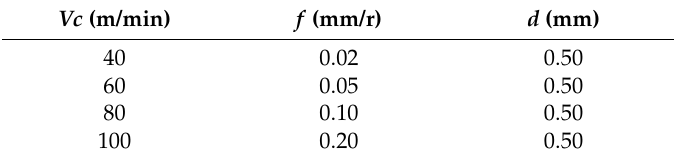
Table 2. Cutting parameters performed in machining test for a total of 16 experiments.